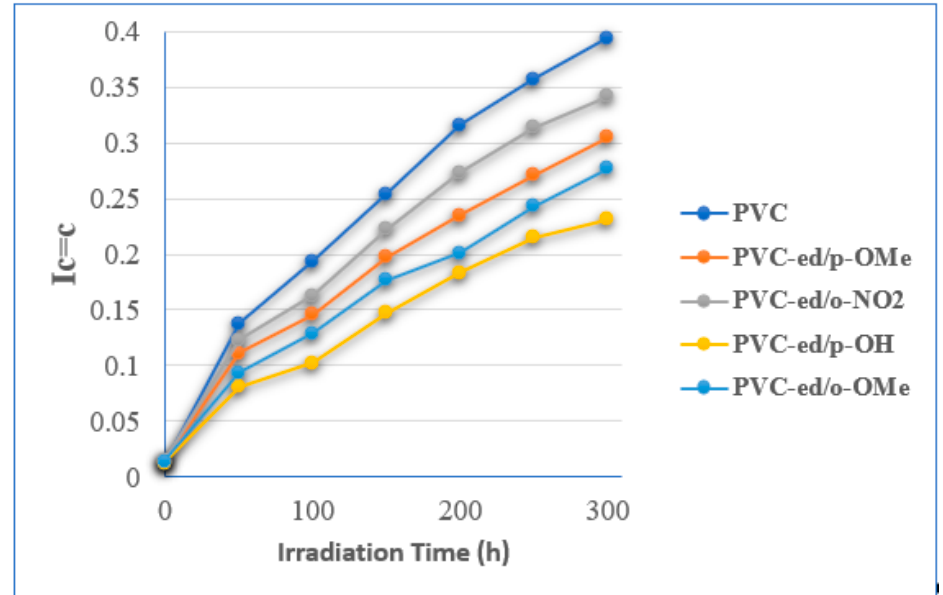
Figure 8. Alkene group index against irradiation time for prepared polymeric films.